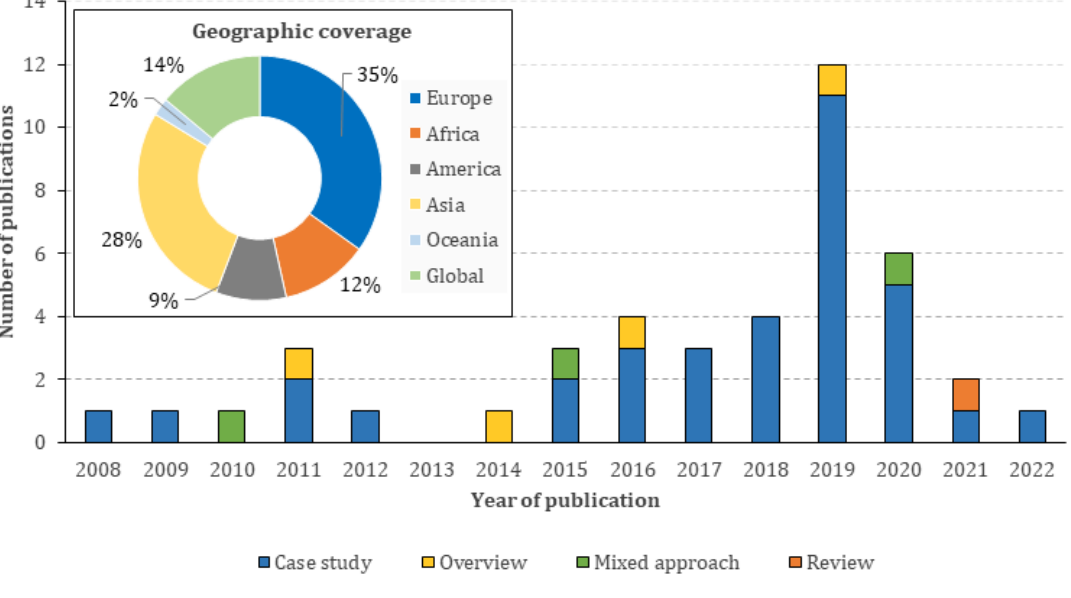
Figure 2. General outlook of the publications reviewed. Table 1. Key information of the literature reviewed.